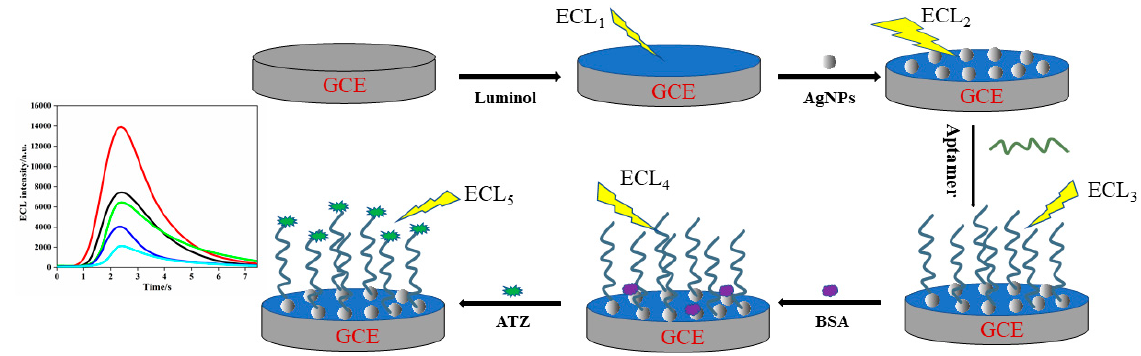
Scheme 1. Schematic illustration for fabricating procedures of the aptasensor.